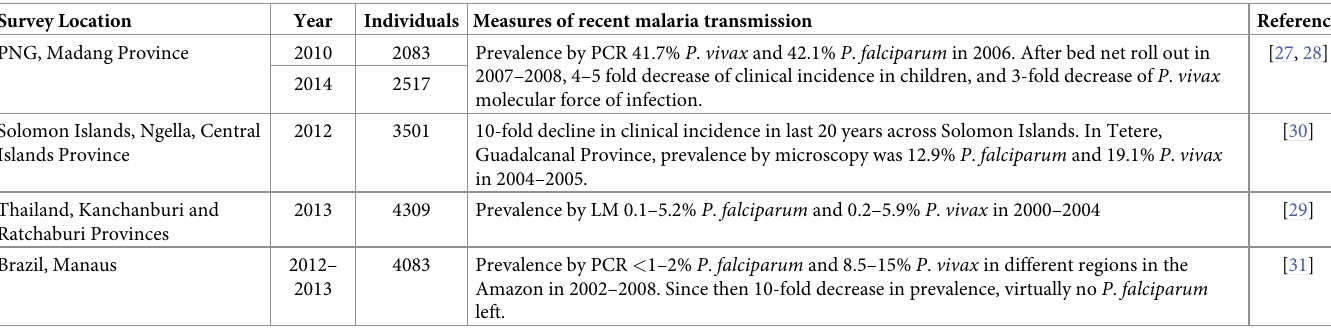
Table 1. Cross-sectional surveys included in this study. Survey